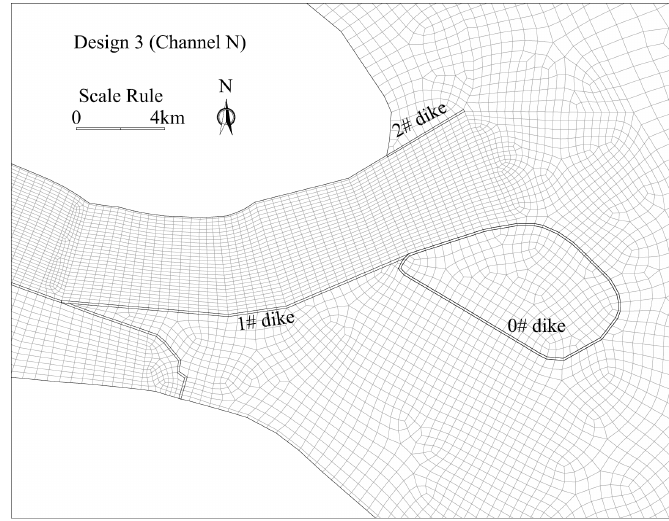
Figure 6. Grid refinement around dikes of the outlet regulation.